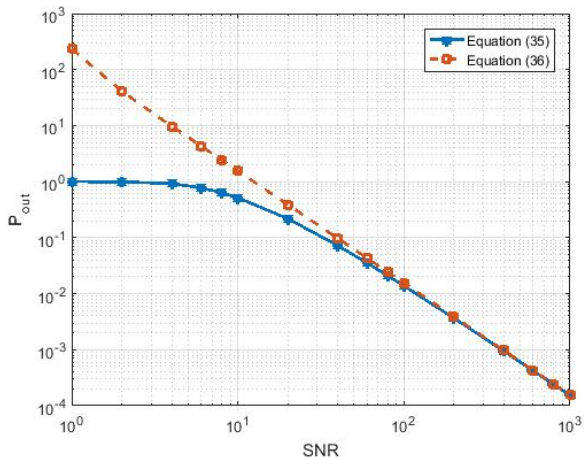
Figure 4. The optimal outage probability comparison of (35) and (36) with different SNR.